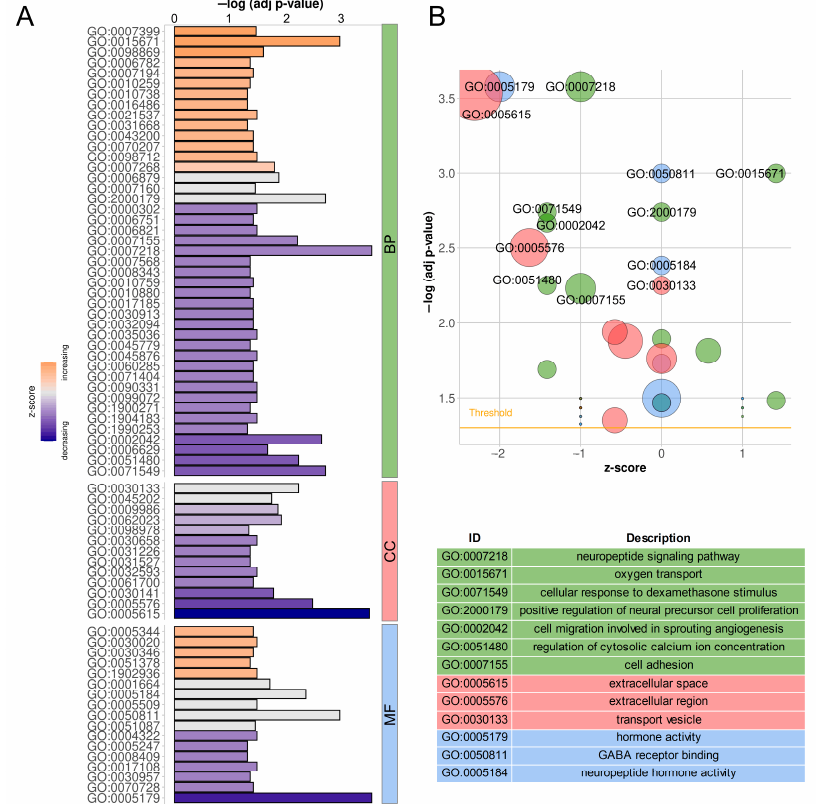
Figure 6. Summary of GO terms enrichment analysis with differentially expressed genes (DEGs). ( A ) The bar plot represents the ratio between up- and downregulated DEGs. Orange bars represent GO terms with the advantage of upregulated DEGs, whereas purple bars show terms that consist of downregulated DEGs, mainly. The GO terms are divided into biological process (BP), cellular component (CC) and molecular function (MF) aspects. The length of the bar indicates the individual terms’ statistical significance levels, obtained during the functional analysis. ( B ) The bubble chart shows the dependence of the normalized ratio of up- and downregulated DEGs (z-score) on the statistical significance level of GO terms. The size of the bubble is proportional to the DEGs abundance identified in the study, classified by the term. The names of the selected GO terms are listed in the table